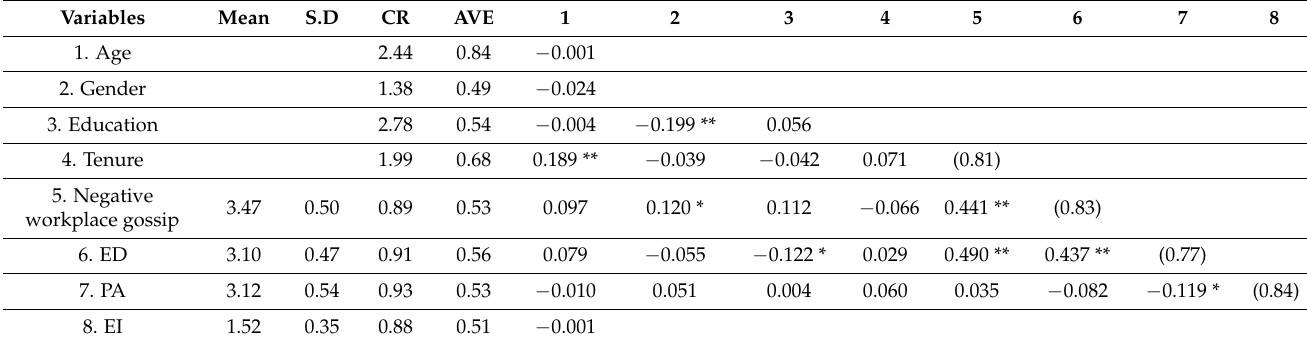
Table 3. Mean, standard deviation, reliability and correlations of this study ( n = 277).